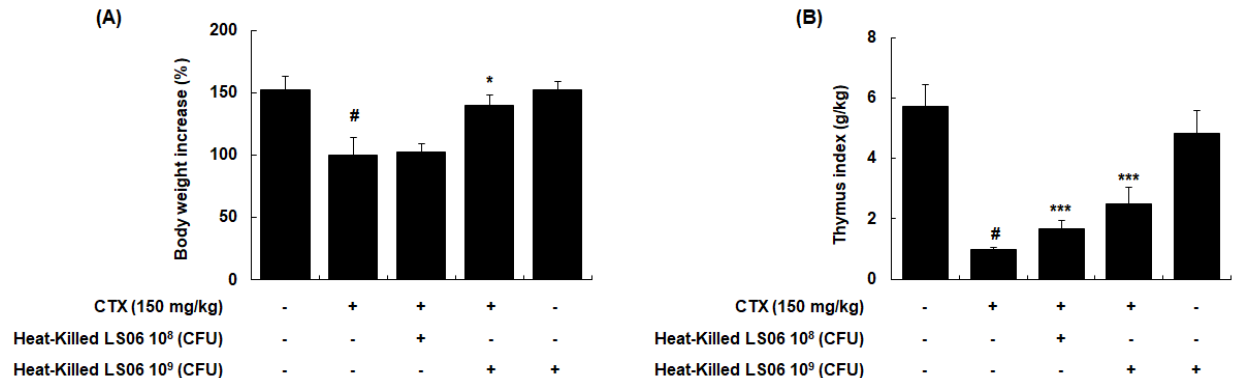
Figure 5. Comparison of ( A ) body weight and ( B ) thymus index between CTX and heat-killed LS06 treatment in mice. Thymus index was calculated as thymus weight (g)/body weight (kg). Data are presented as the mean ± SEM ( n = 10). # p < 0.05 vs. Con group; * p < 0.05, *** p < 0.001 vs. CTX group.